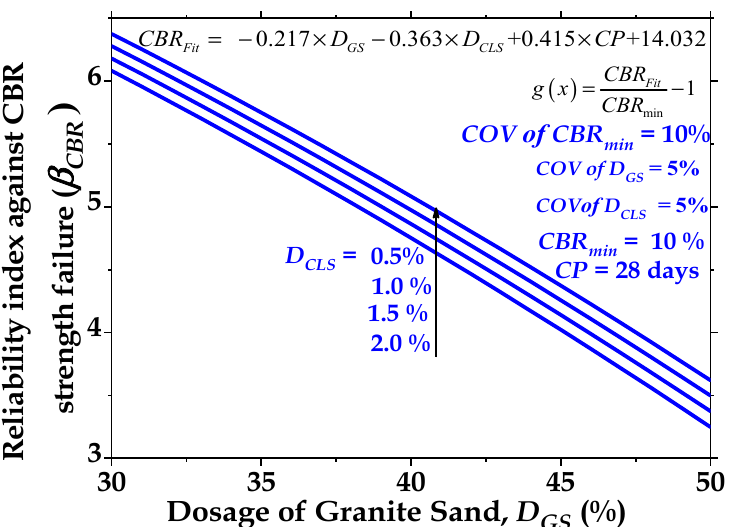
Figure 16. Effect of dosage of CLS (D CLS ) on reliability index against CBR strength failure ( β CBR ) Figure 16. Effect of dosage of CLS ( D (cid:2887)(cid:2896)(cid:2903) ) on reliability index against CBR strength failure ( β (cid:2887)(cid:2886)(cid:2902) ) Figure 16. Effect of dosage of CLS ( D (cid:2887)(cid:2896)(cid:2903) ) on reliability index against CBR strength failure ( β (cid:2887)(cid:2886)(cid:2902) ) with dosages of granite sand (D GS ) for curing period (CP) = 28 with dosages of granite sand ( D (cid:2891)(cid:2903) ) for curing period (CP) = 28 days. with dosages of granite sand ( D (cid:2891)(cid:2903) ) for curing period (CP) = 28 days.